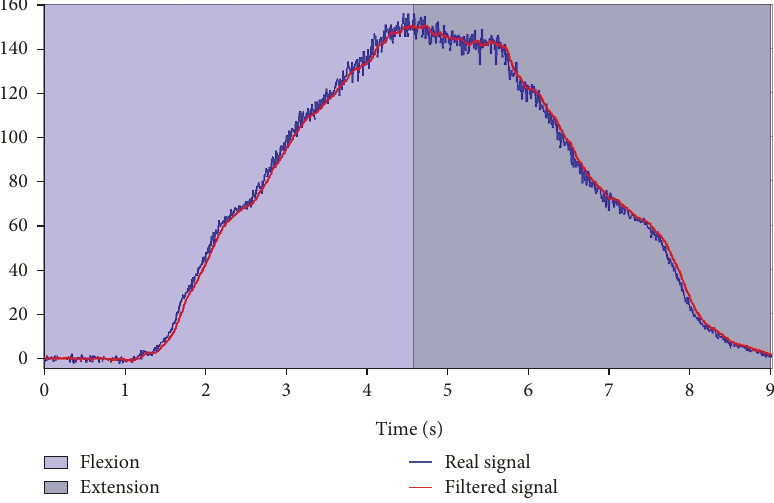
Figure 13: Elbow joint time response for fl exion-extension movements.